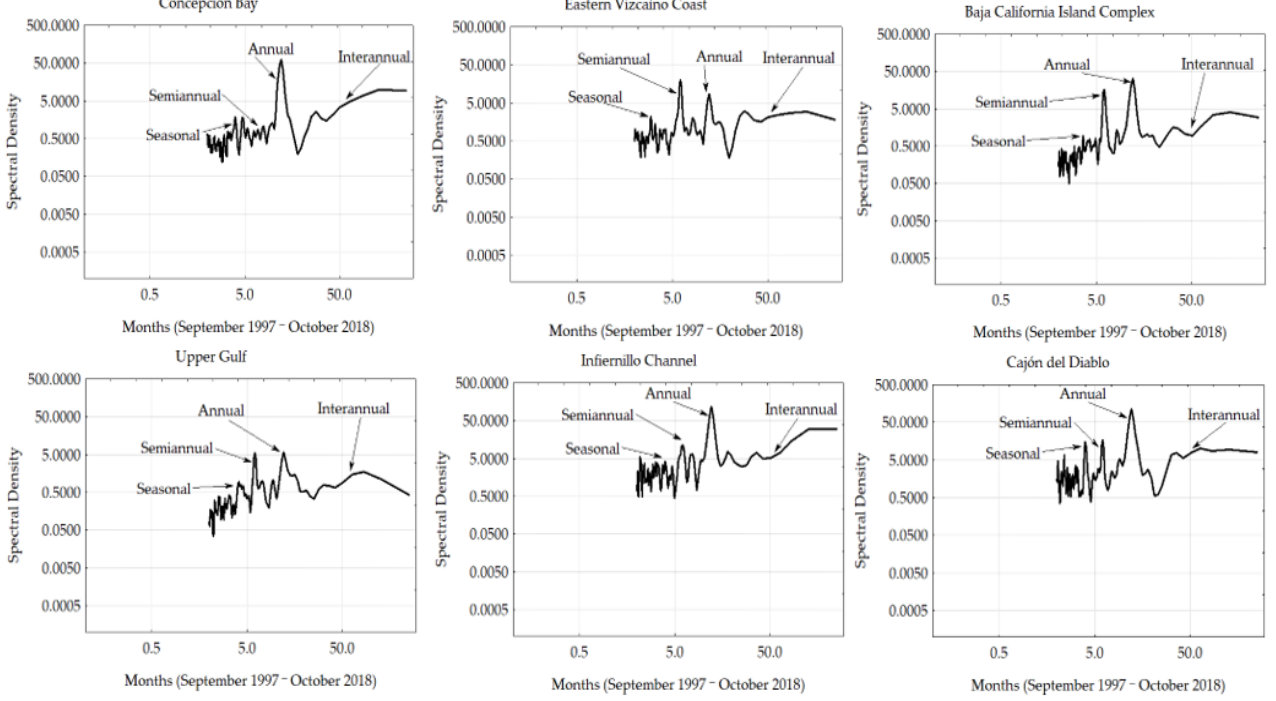
Figure 8. Fourier analyses of Chlorophyll a (Chl a ) concentration for the regions of the Northwest of Mexico (Concepción Bay, Eastern Vizcaíno Coast, Baja California Complex Island, Upper Gulf, Infiernillo Channel and Cajón del Diablo).